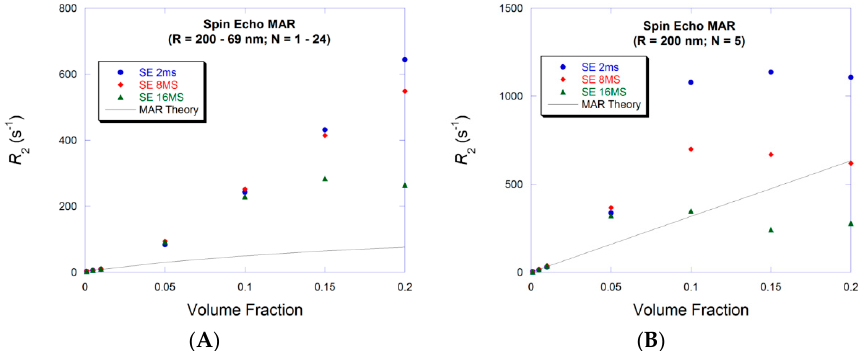
Figure 7. R 2 values are plotted vs. particle volume fraction for particles within MAR. ( A ) The particle size is increased while the radius is decreased to achieve increasing volume fraction. ( B ) The particle size and radius are kept constant while the sample space is decreased to achieve increasing volume fraction. R 2 values approach R 2 * (Figure 6) for each particle size arrangement. MAR theory underestimates R 2 simulated values.